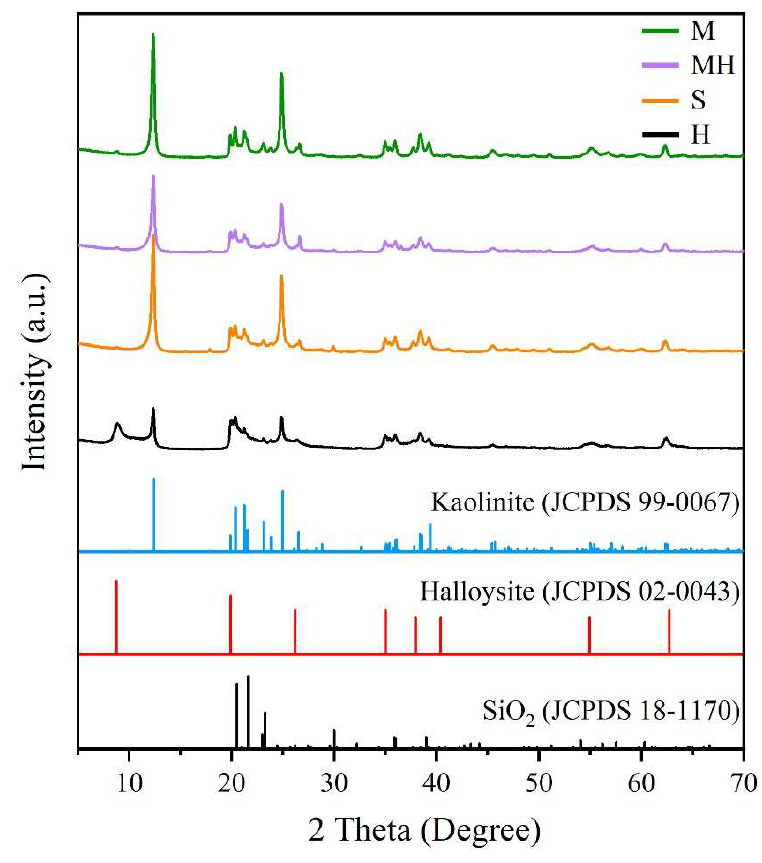
Figure 4. XRD pattern of the samples.